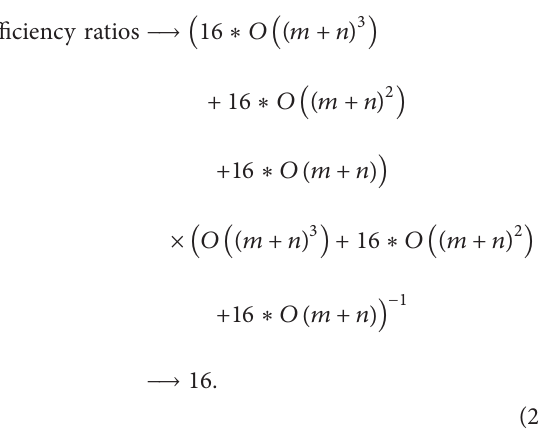
To refine the nodes domain, the NG will be a large number. The elapsed CPU times of compute shape functions is far than the rest.